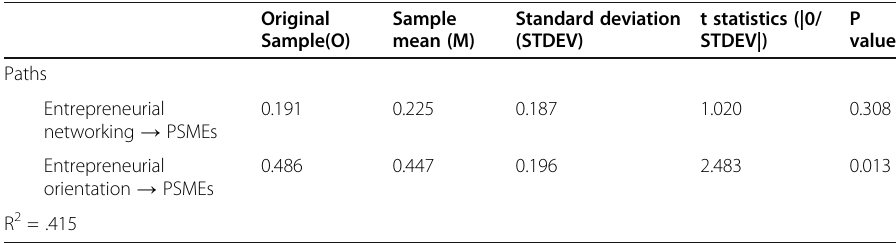
Table 4 Direct path coefficients